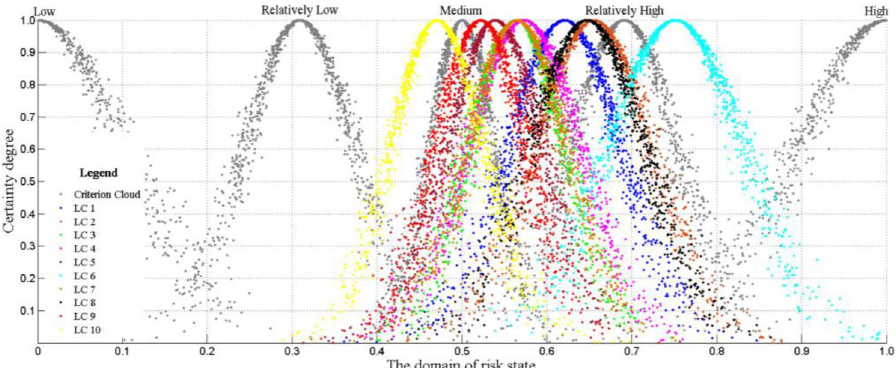
Figure 5. Cloud chart of loess collapsibility risk grade of pipeline.